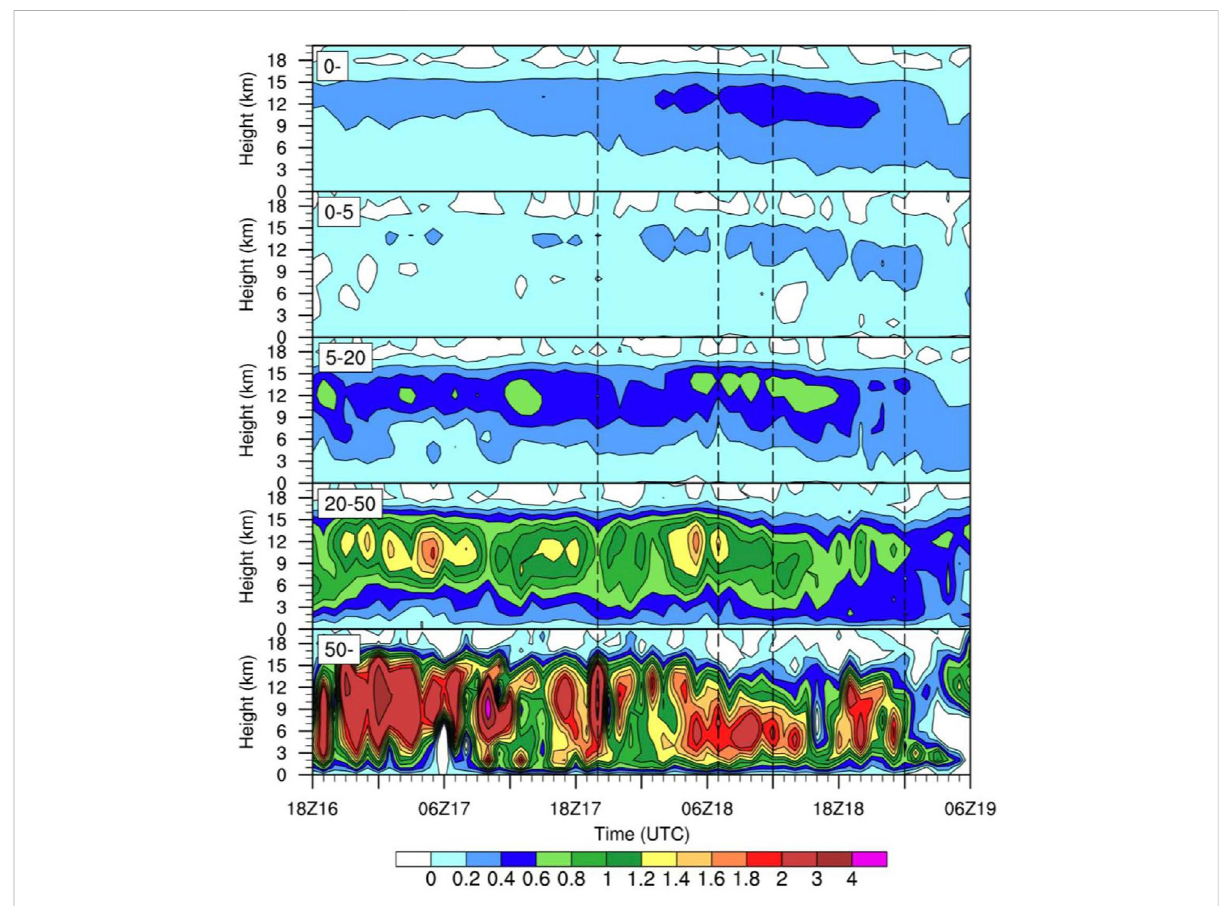
FIGURE 6 Theheight-timechangesoftheaverageverticalvelocity(unit:ms − 1 )ofdifferenthourlyrainfallintensities inthegale circle.Themeaningsofthe vertical dotted lines are as same as Figure